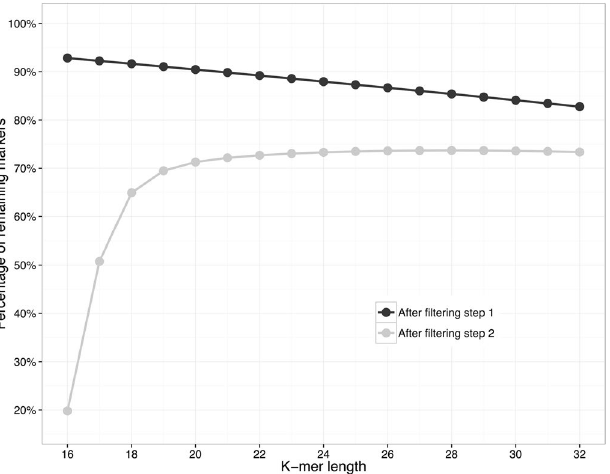
Figure 5. Effect of k -mer length on filtering SNV markers. Lines show the fraction of remaining markers after filtering steps 1 and 2. The step 1 removes SNVs that have other marker within k nucleotides on both sides. The step 2 removes SNVs that have no unique k -mers in the expanded reference genome. Y-axis indicates the fraction of remaining markers after each filtering step. 100% in this figure corresponds to 46,954,719 SNVs from the dbSNP that were fed to filtering pipeline.